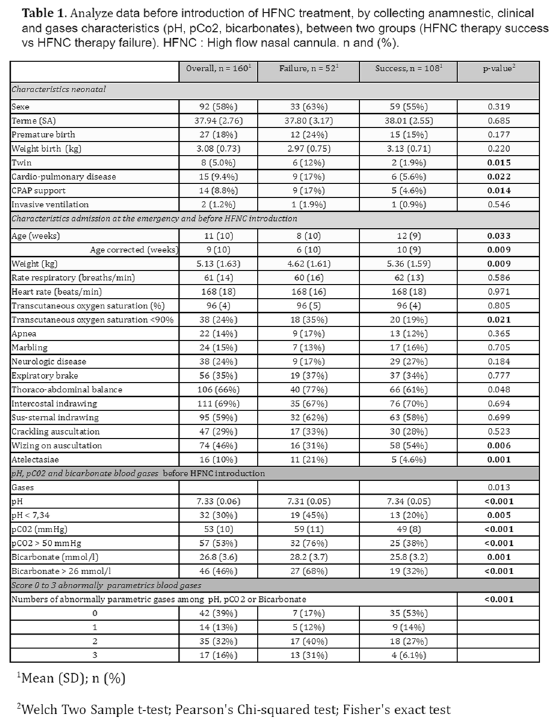
Table 1. Analyze data before introduction of HFNC treatment, by collect- ing anamnestic, clinical and blood gas characteristics (pH, pCO 2 , bicar- bonates), between two groups (HFNC therapy success vs HFNC therapy failure). HFNC: High flow nasal cannula. n and